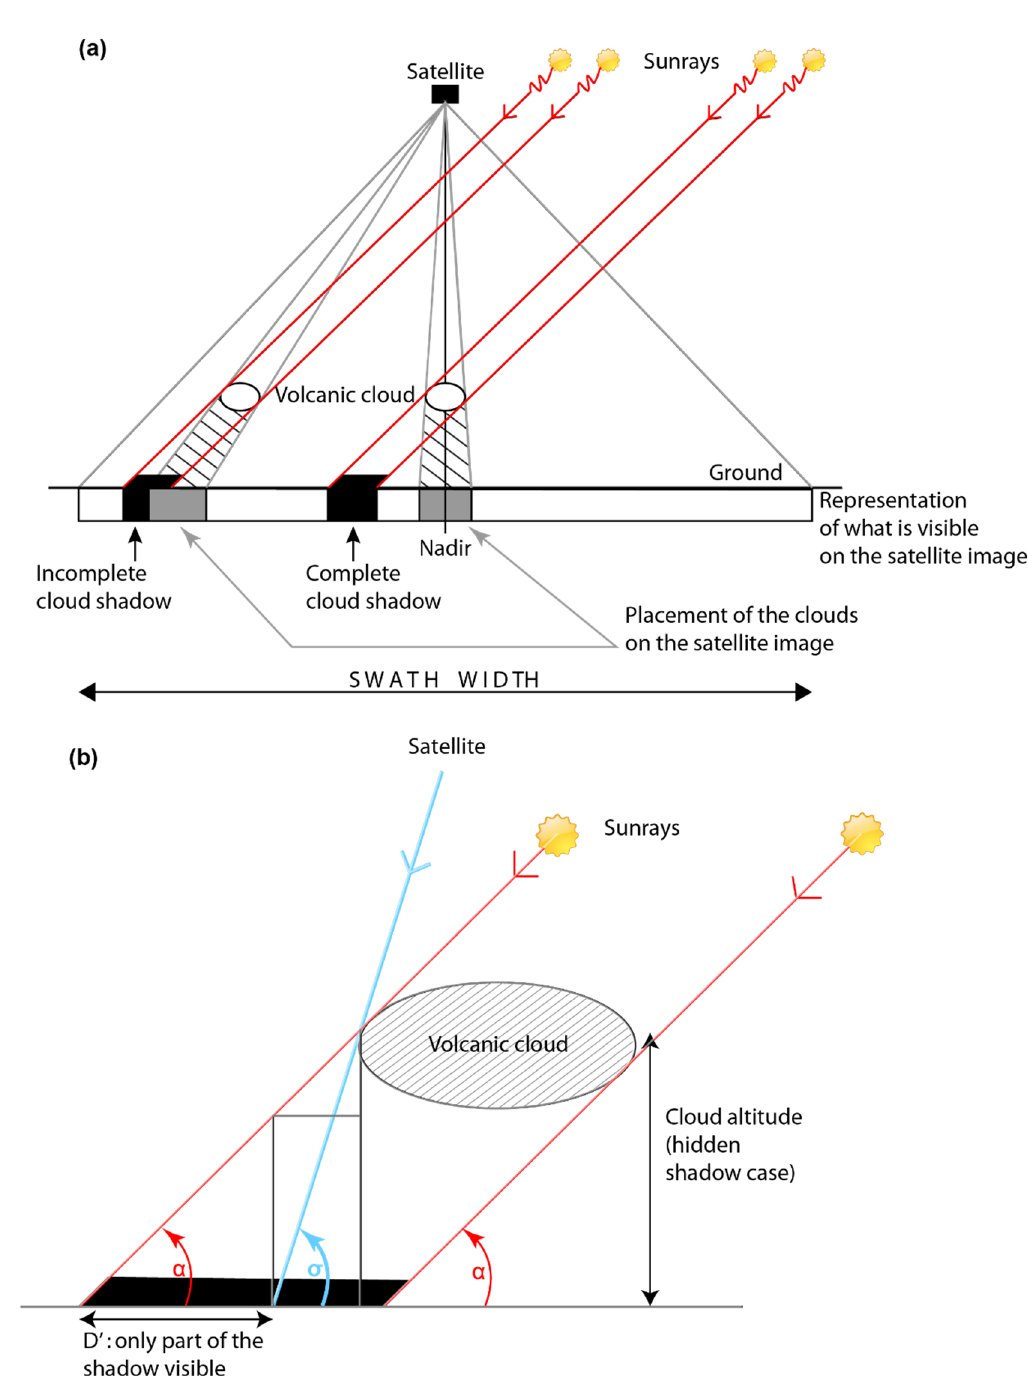
Figure 3. Satellite and Sun viewing geometry responsible for a “missing” shadow portion. ( a ) General geometry. ( b ) Detailed geometry for the case where a portion of the shadow is hidden.